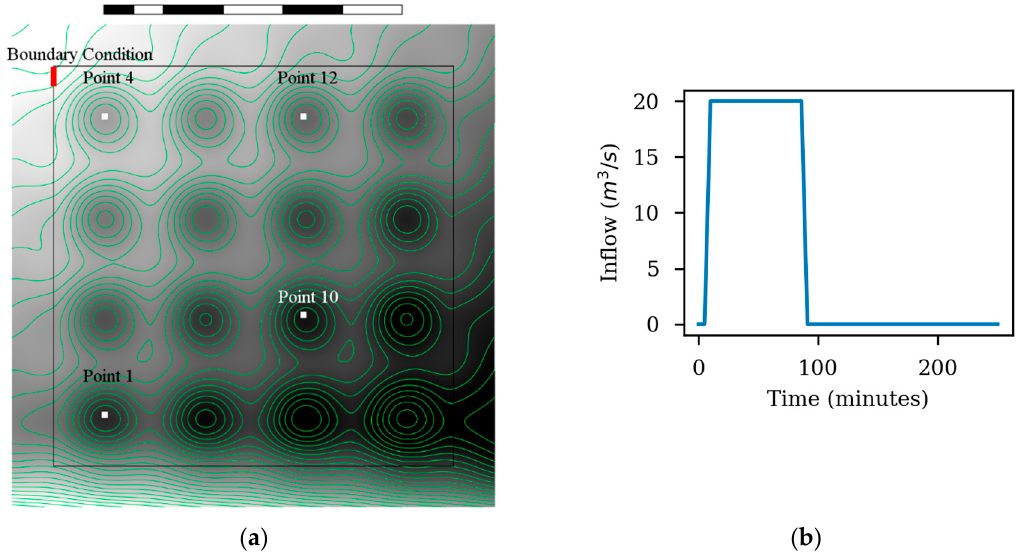
Figure 6. Setup of Test 2. ( a ) Shows the simulated domain. White areas represent higher elevations. The inlet boundary condition is marked in red. The measurements were performed in the points shown above; ( b ) Hydrograph used for the inlet boundary condition.